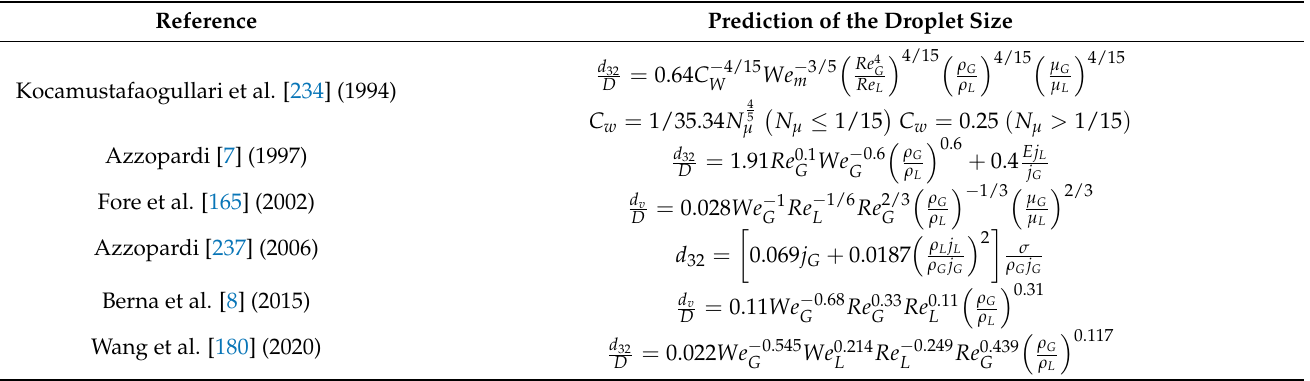
Table 3. Predictions of the drop size in an annular